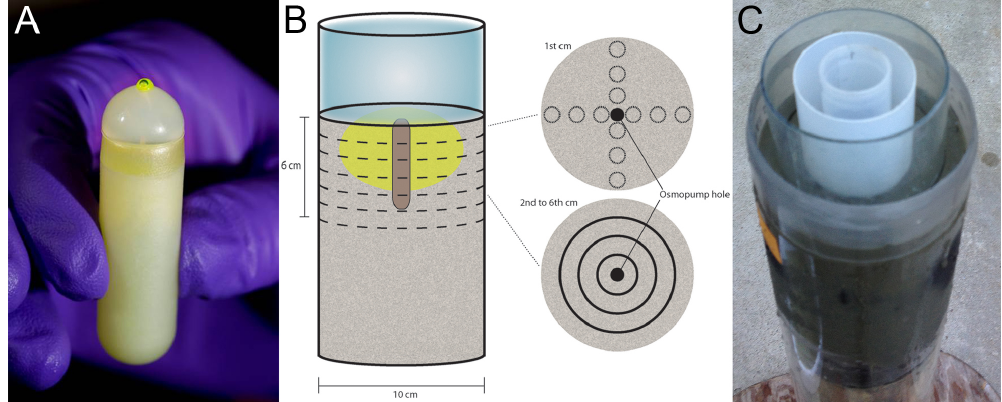
Figure 1. (a) ALZET ® 2ML4 osmotic pump filled with concentrated calcein. The visible calcein at the top is emanating from the pump’s port. (b) Schematic of sediment core and overlying water with osmotic pump in place (left) and of two sediment collection approaches: one for the top 1cm layer, using 3mL syringe cores (right, top); the other for underlying layers, using concentric rings (right, bottom). Yellow ovoid is the theoretical dispensation of calcein from the osmotic pump emplaced port up in core. (c) Image showing concentric rings in place prior to section slicing. Core is 10cm in